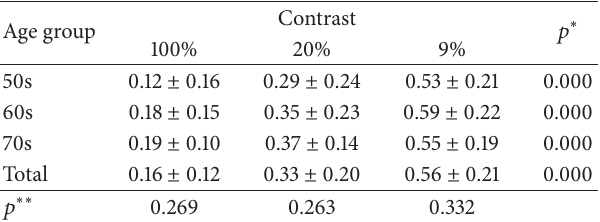
Table 3: Simulated visual acuity (mean VA logMAR ± SD) of pseu- dophakic eyes ( 𝑁 = 143 ) at different simulated contrast levels, compared by age